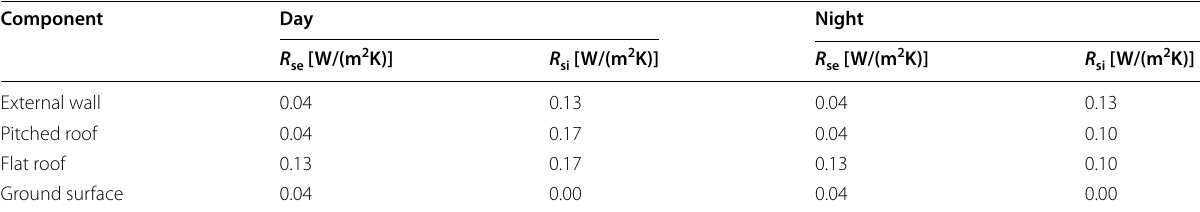
Table 2 External and internal heat transfer resistances of the building components and ground surfaces used within the one- dimensional model calculations (Maiullari et al.